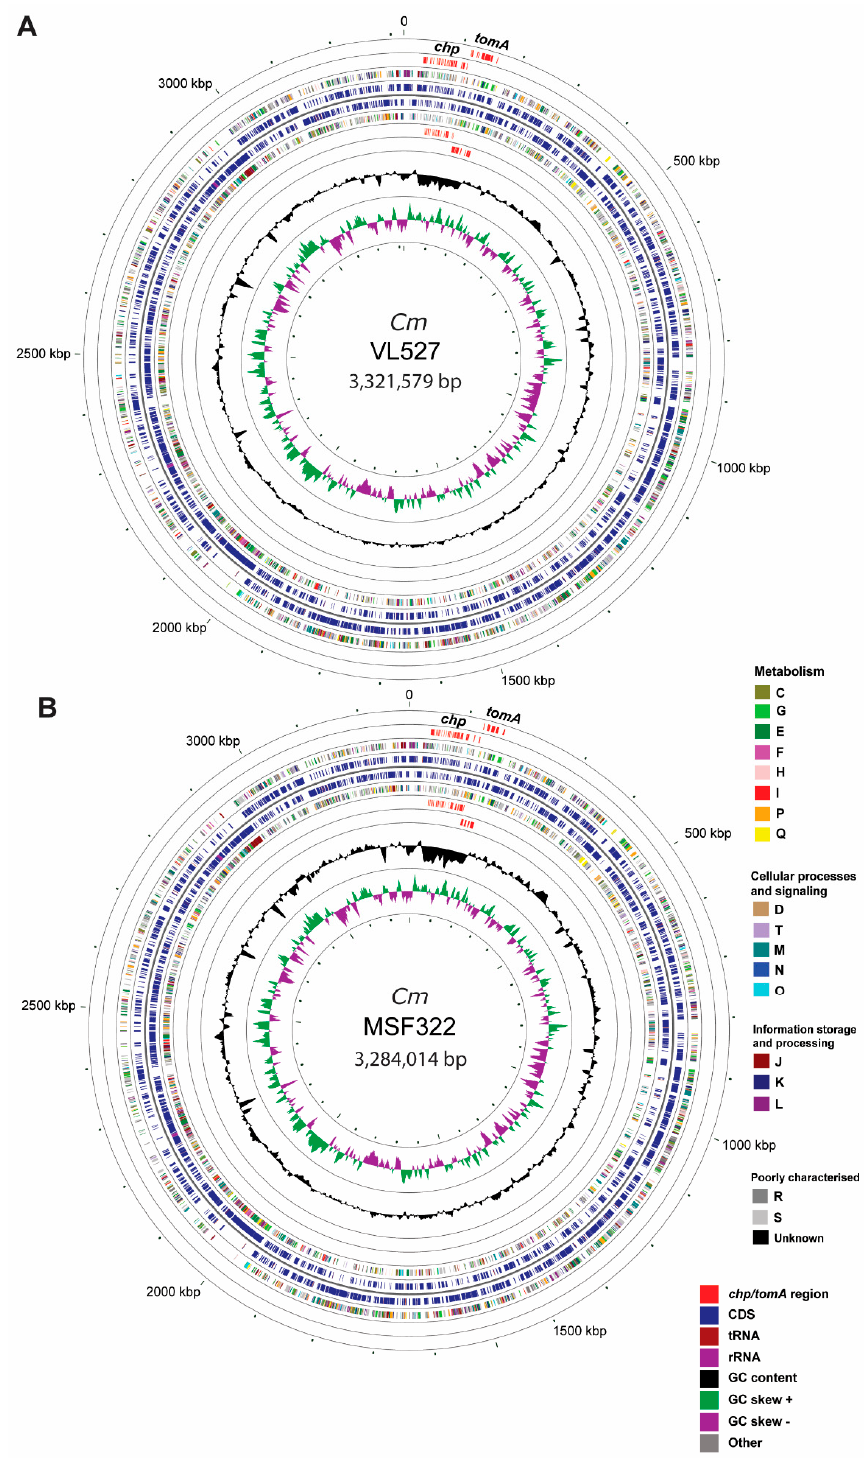
Figure 2. Schematic representation of the chromosomes of the Chilean strains VL527 and MSF322. The chromosome of C. michiganensis subsp. michiganensis strain VL527 has a size of 3,321,579 bp, 3067 coding sequences, 6 rRNA, and 52 tRNA ( A ); the chromosome of strain MSF322 has a size of 3,284,014 bp, 3039 coding sequences, 6 rRNA, and 53 tRNA ( B ). Rings from inside to outside: GC skew ( +/ − ) (1); GC content (2); Predicted genes in reverse strand (4); Predicted genes in forward strand (5); predicted pathogenicity island ( chp / tomA region) in reverse and forward strands based on BLASTN (3,6) (7). Gene function predictions were annotated, based on clusters of orthologous groups (COG) categories. The chromosome maps were generated, using